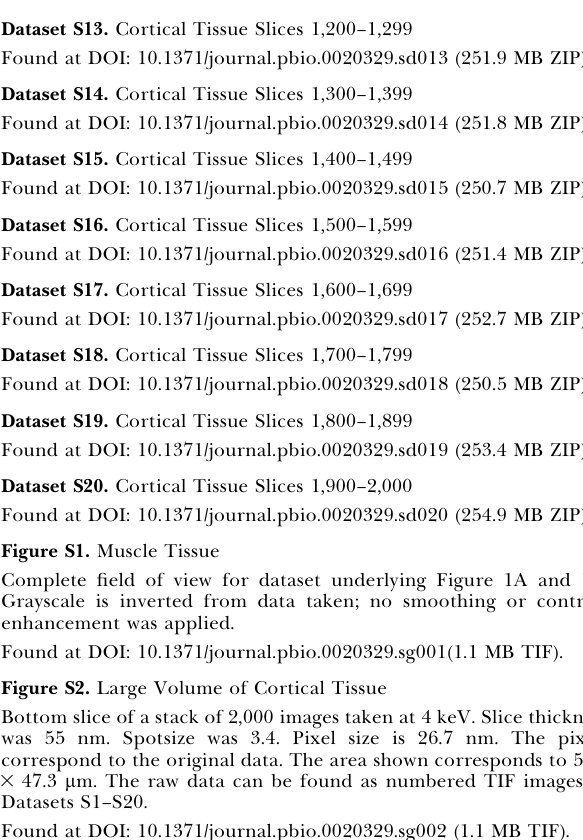
Figure S1. Muscle Tissue Complete field of view for dataset underlying Figure 1A and 1B. Grayscale is inverted from data taken; no smoothing or contrast enhancement was applied. Found at DOI: 10.1371/journal.pbio.0020329.sg001(1.1 MB TIF). Figure S2. Large Volume of Cortical Tissue Bottom slice of a stack of 2,000 images taken at 4 keV. Slice thickness was 55 nm. Spotsize was 3.4. Pixel size is 26.7 nm. The pixels correspond to the original data. The area shown corresponds to 54.8 3 47.3 l m. The raw data can be found as numbered TIF images in Datasets S1–S20. Found at DOI: 10.1371/journal.pbio.0020329.sg002 (1.1 MB TIF). Figure S3. Large Volume of Cortical Tissue: X-Resliced Stack Same volume data as used for Figure S2. The stack was resliced along the horizontal dotted line shown in Figure S2. In the vertical direction the data were interpolated so that each slice now corresponds to slightly more that two pixels. Horizontal white lines are slices with deposited debris. The total stack height was 110 l m. Figure S4. Large Volume of Cortical Tissue: Y-Resliced Stack Same as Figure S3 but now resliced along the vertical dotted line in Figure S2. Found at DOI: 10.1371/journal.pbio.0020329.sg004 (7.1 MB TIF). Figure S5. Neurite Reconstruction Manual reconstruction of selected processes in cortical tissue (data from Video 2 and Figure 5). Blue, portion of proximal apical dendrite; green, secondary dendrite with three synaptically con- nected axons (yellow, ocher, and mauve). Insets show the synaptic contacts. Also shown is a passing axon that is not synaptically connected within the volume analyzed. Only the lower part of the stack, which was taken at 4 keV electron energy, was used. Found at DOI: 10.1371/journal.pbio.0020329.sg005 (1.7 MB